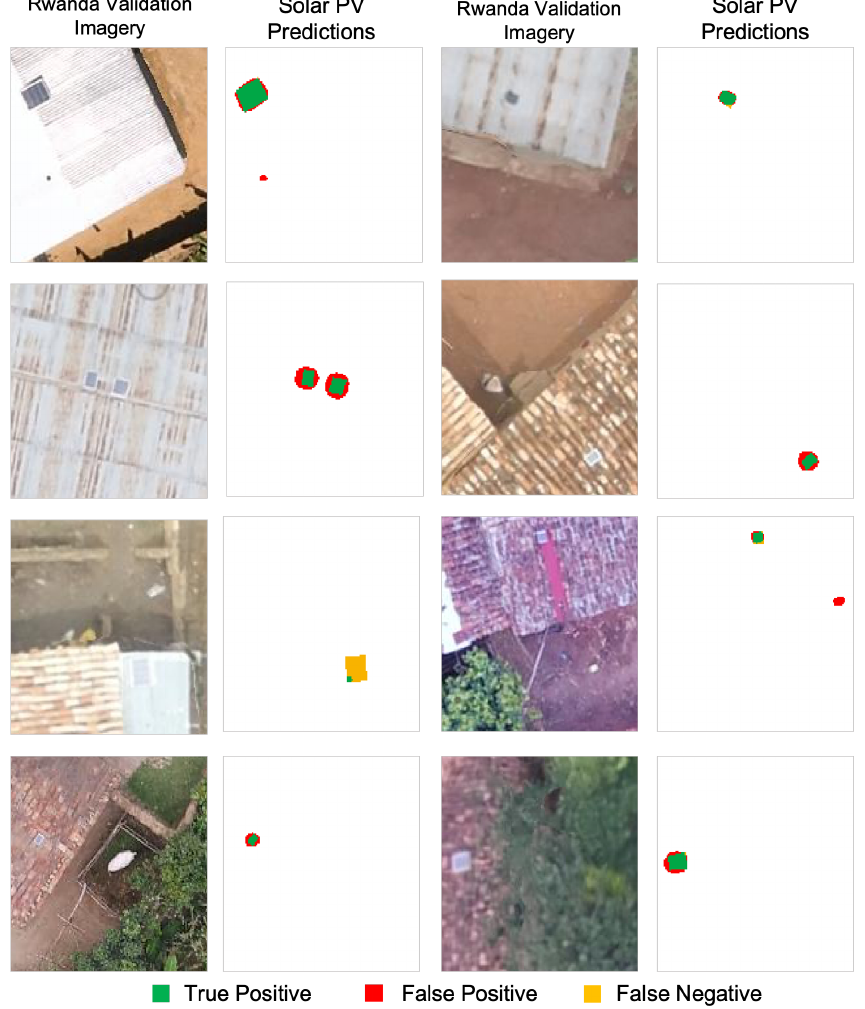
Figure 8. Sample predictions from the Rwanda dataset. Left columns are the imagery patches and right columns show the output of the predictions. Green represents true positives, which are corrected labeled solar panel pixels. Red represents false positive, which occurs when the algorithm predicted a solar panel where there was none. Orange represents false negatives, which are actually solar panels, but were not